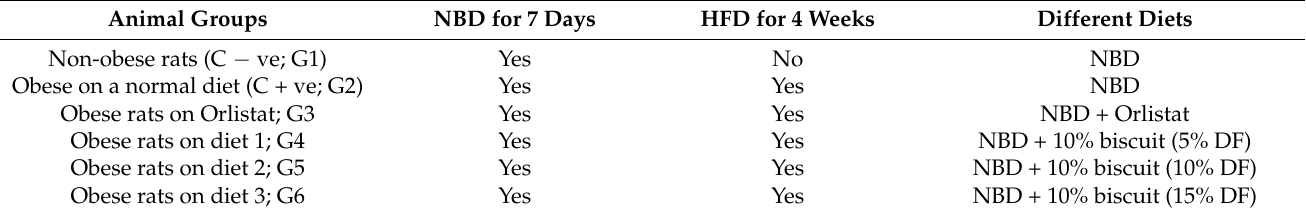
Table 1. The study design and diets used with biscuits supplemented with different DF levels between groups of